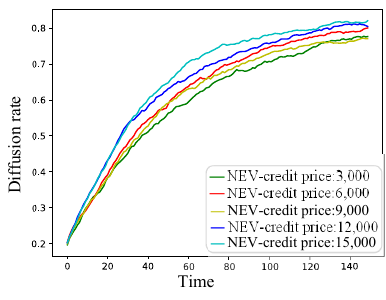
Figure 14. Sale profit, Scale free.